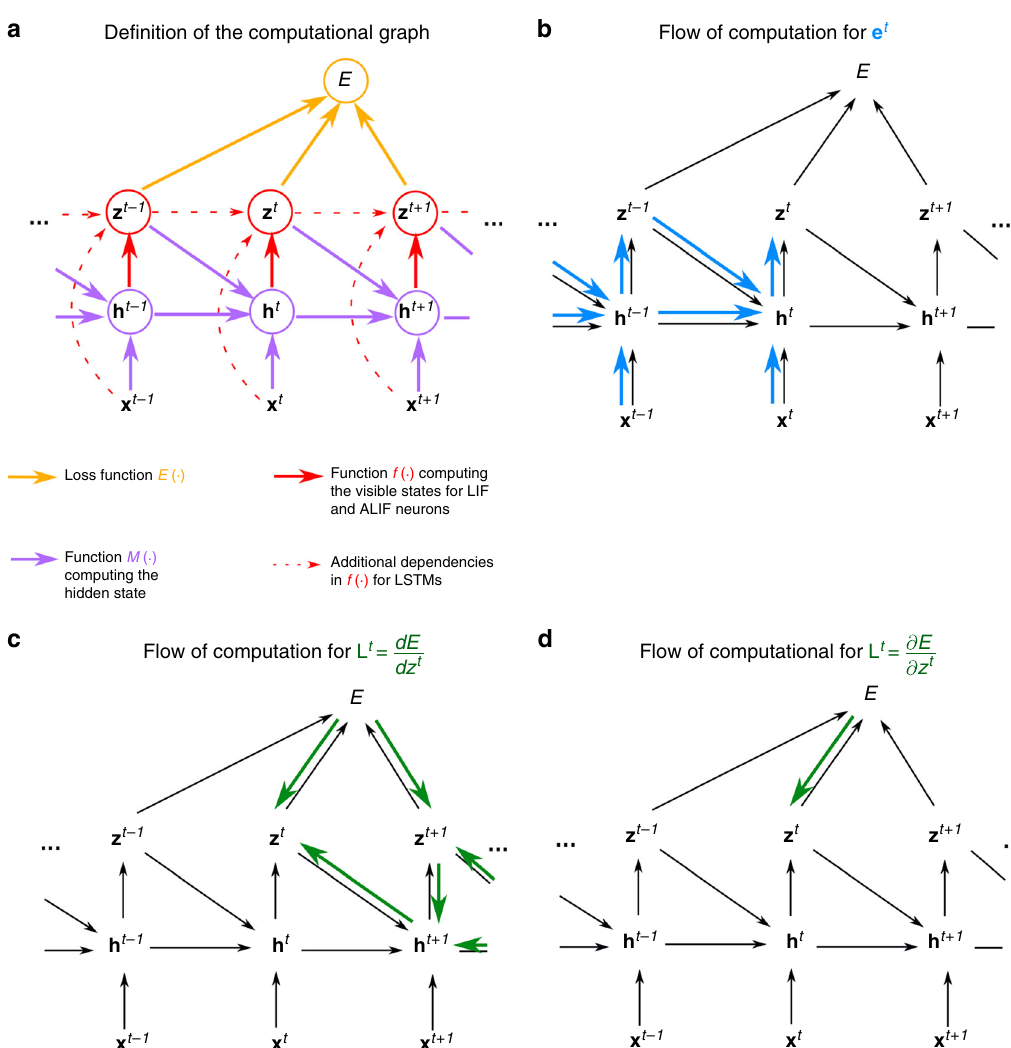
Fig. 6 Computational graph and gradient propagations. a Assumed mathematical dependencies between hidden neuron states h t j , neuron outputs z t , network inputs x t , and the loss function E through the mathematical functions E ( ⋅ ), M ( ⋅ ), f ( ⋅ ) are represented by colored arrows. b – d The fl ow of computation for the two components e t and L t that merge into the loss gradients of Eq. (3) can be represented in similar graphs. b Following Eq. (14), the dE fl ow of the computation of the eligibility traces e t L t j ¼ ji is going forward in time. c Instead, the ideal learning signals dz t j requires to propagate gradients backward in time. d Hence, while e t ji is computed exactly, L t j is approximated in e-prop applications to yield an online learning